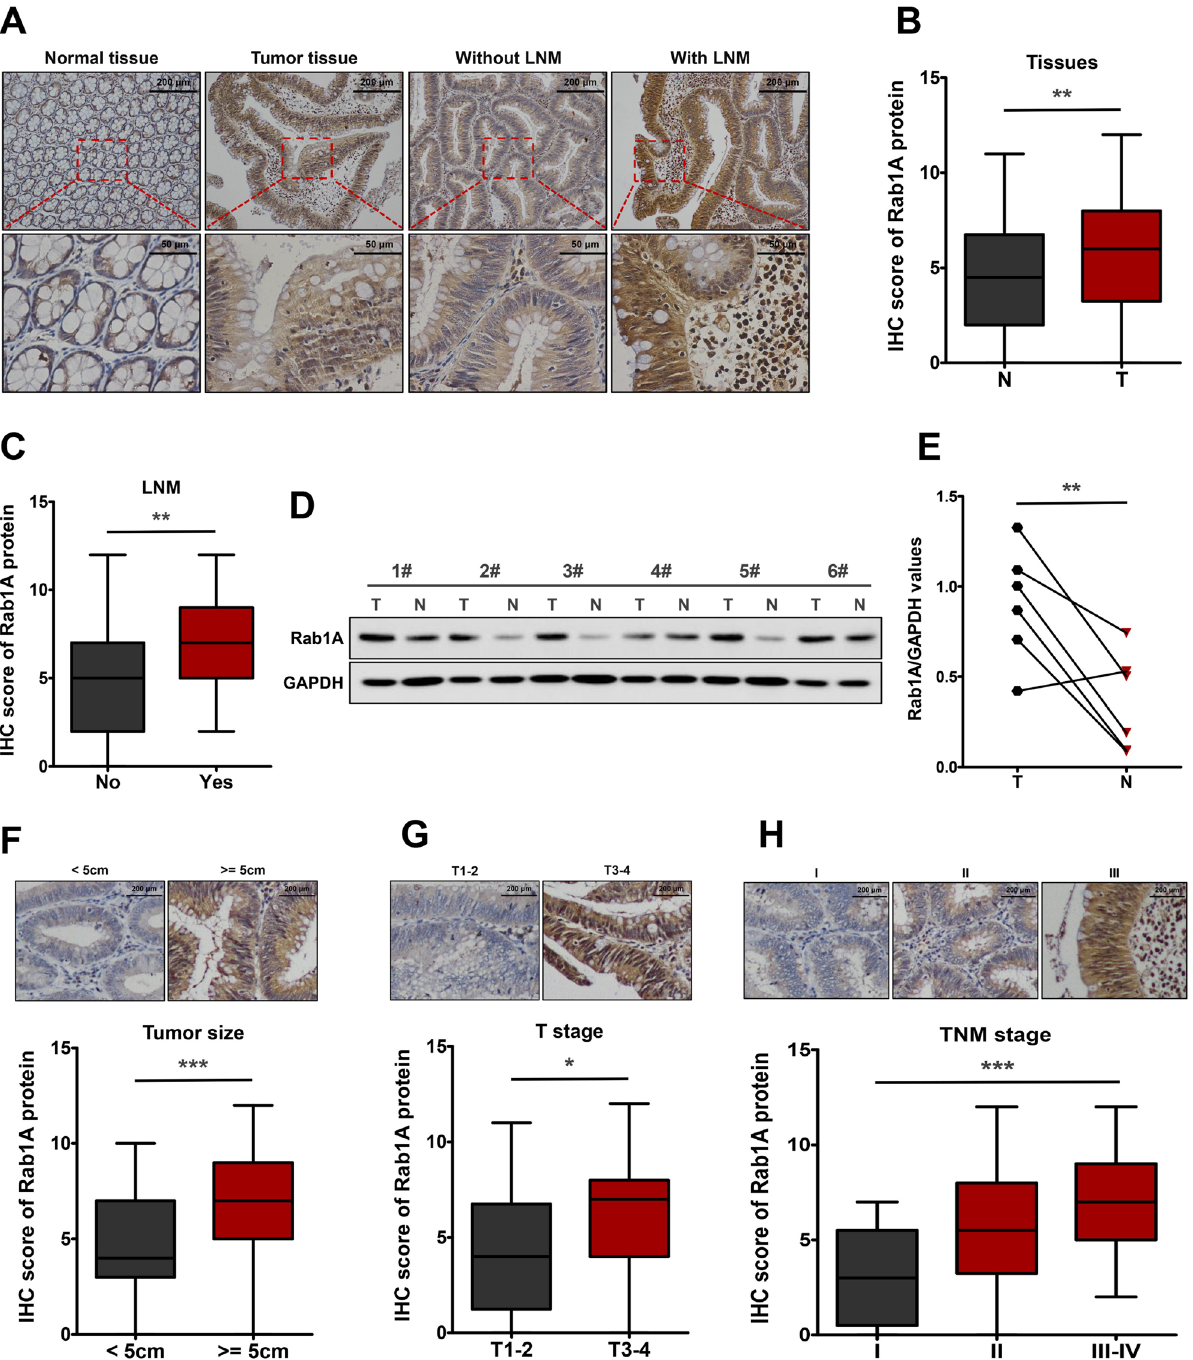
Figure 1. Rab1A is upregulated in CRC tissues. ( A ) IHC staining of Rab1A in CRC tumor tissues and the surrounding normal tissues. ( B ) IHC scores of Rab1A in CRC tumor tissues (T) and normal tissues (N). ( C ) IHC scores of Rab1A in CRC tumors with or without LNM. ( D ) Rab1A protein expression in six pairs of CRC tumors (T) and surrounding normal tissues (N) as detected by Western blotting. ( E ) Scatter plot analysis of Rab1A/GAPDH values in six paired CRC samples. ( F ) IHC staining and IHC scores of Rab1A in CRC tumors with different size. ( G ) IHC staining and IHC scores of Rab1A in CRC tumors with different T stage. H. IHC staining and IHC scores of Rab1A in CRC tumors with different TNM stage. Here cropped blots were displayed and all full-length blots are included in the Supplementary Information file. * P < 0.05, ** P < 0.01, *** P <